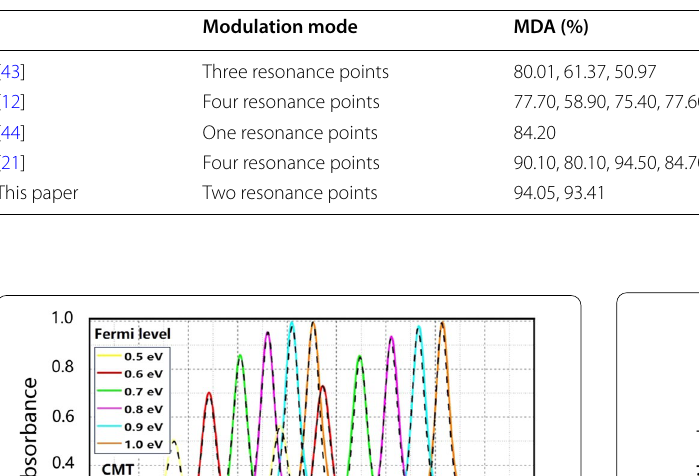
Table 1 Comparison of switches based on single-layer graphene